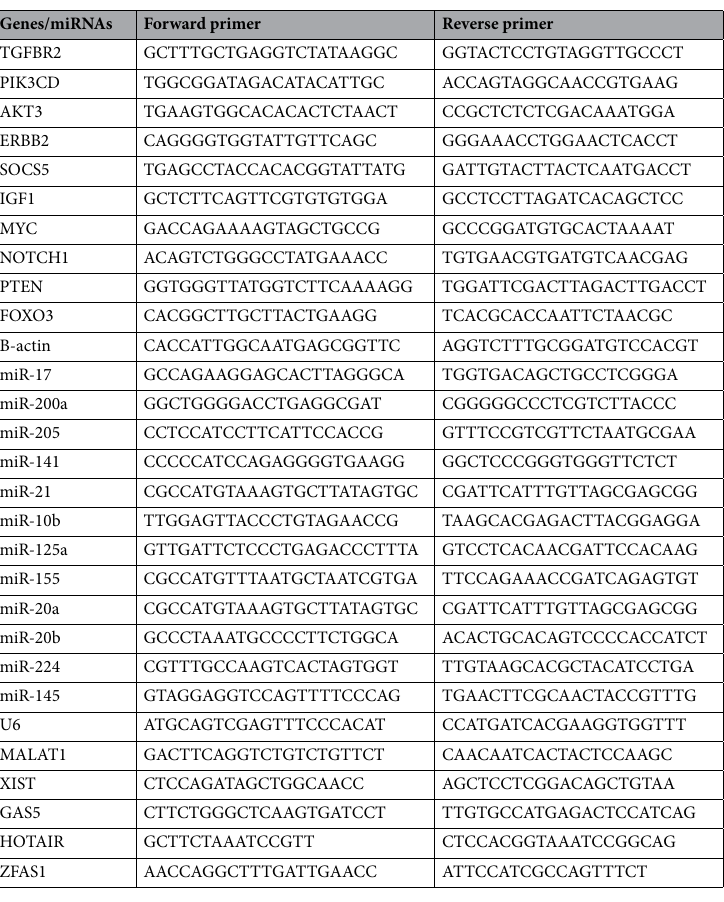
Table 8. The list of primers for real-time